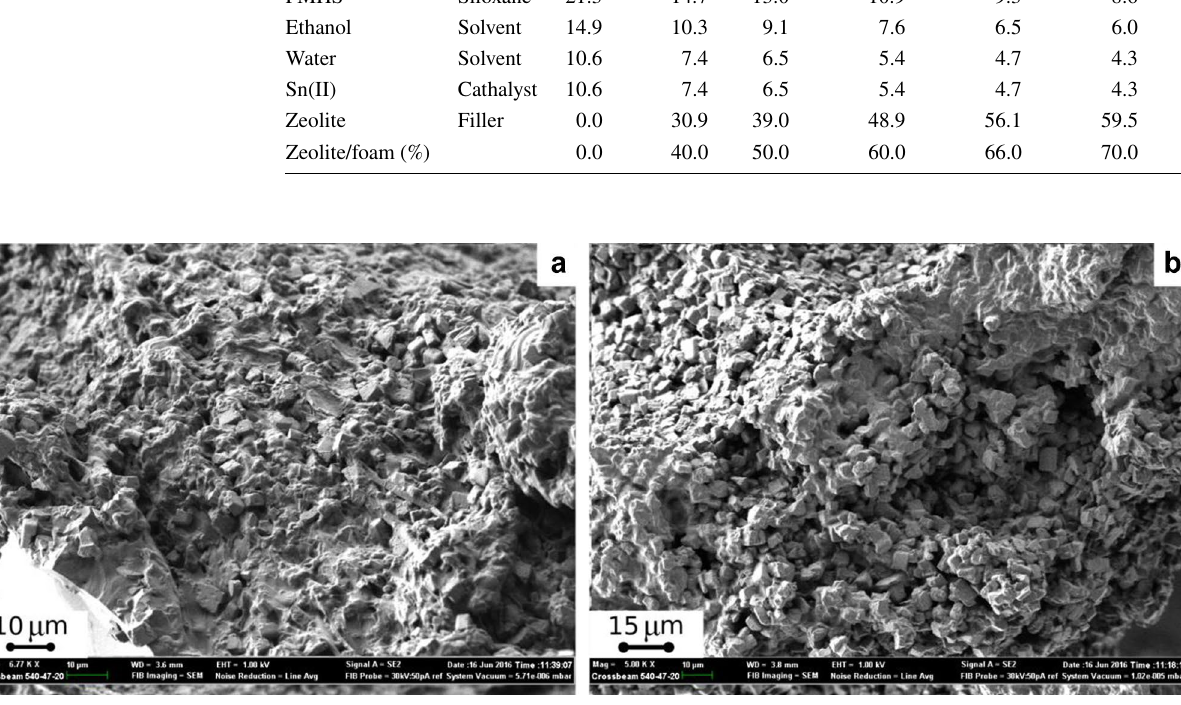
Table 1 Siloxane solution formulations at varying zeolite filler content